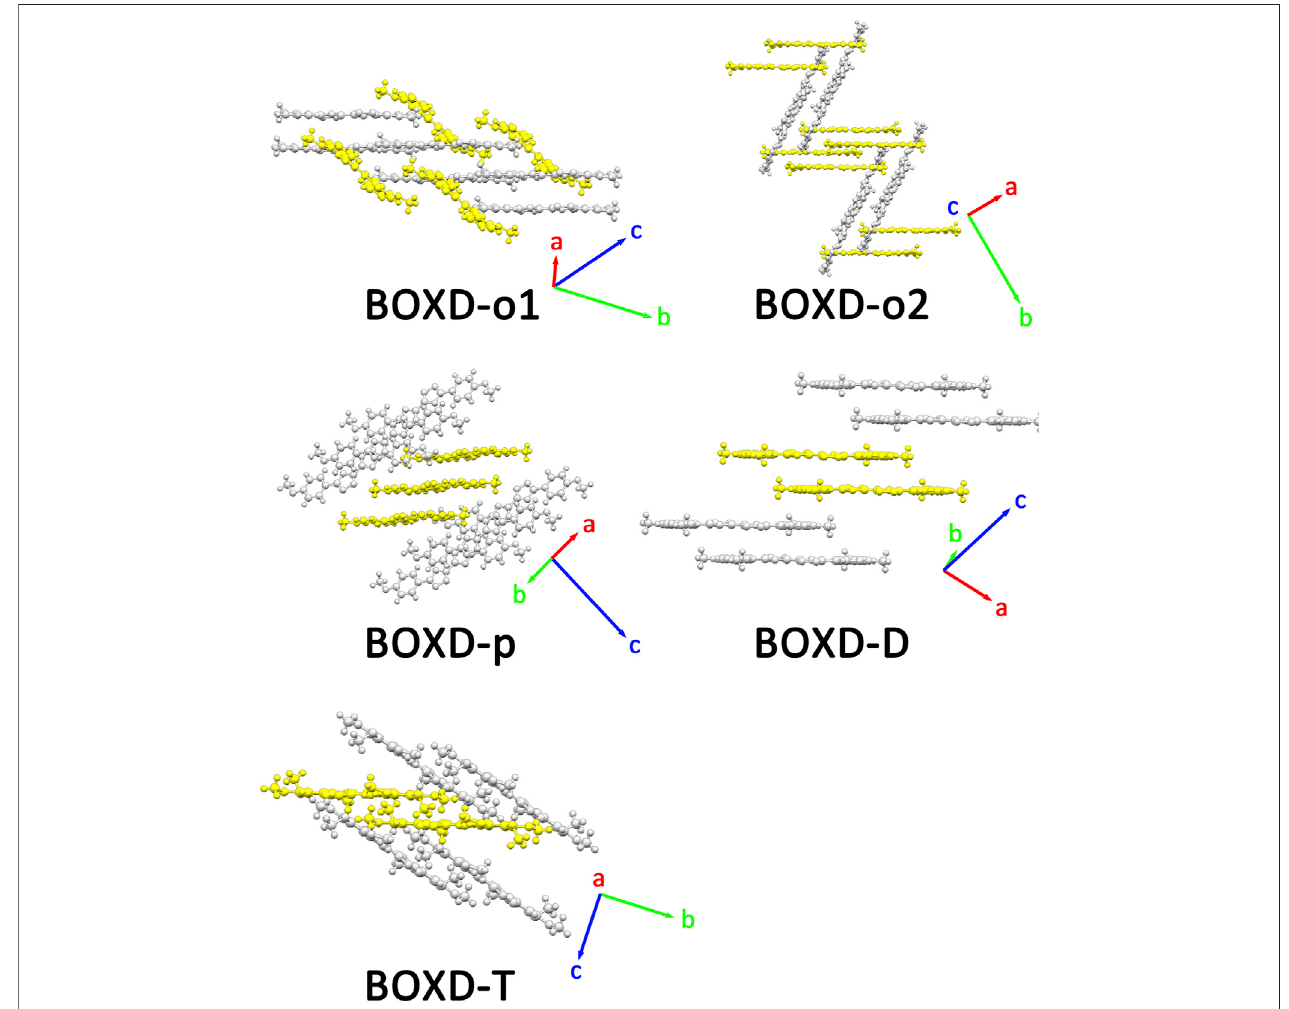
FIGURE 2 | Crystal structures and crystal cell directions of BOXD-o1 , BOXD-o2 , BOXD-p , BOXD-D , and BOXD-T .